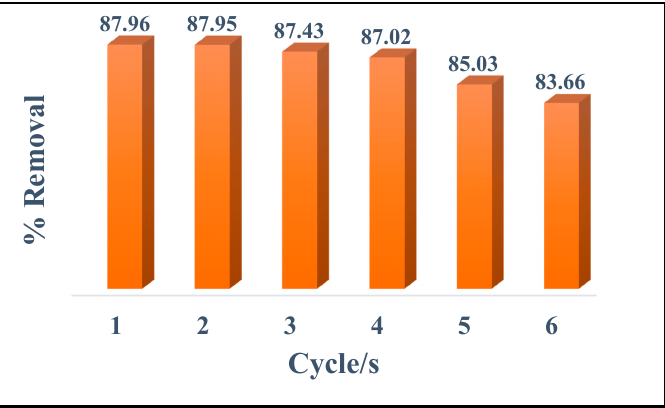
Figure 10. Recyclability test of the nano ‐ adsorbent for the remediation of Cd 2+ .